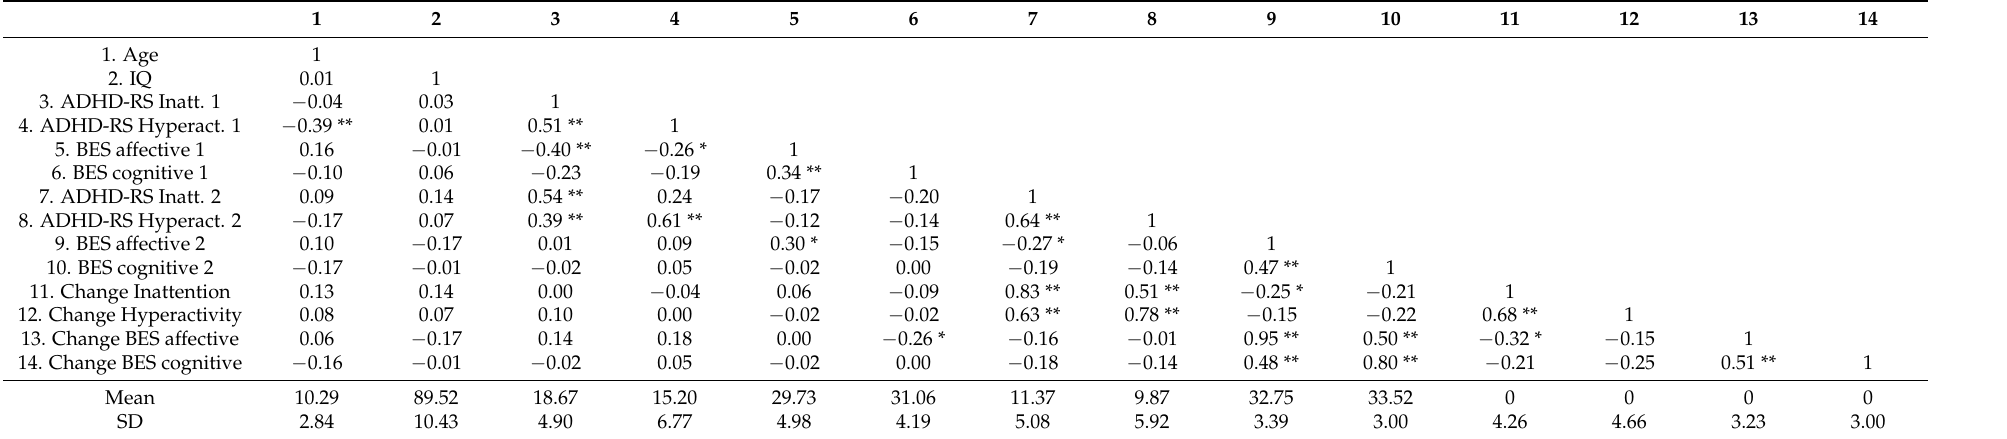
Table 1. Correlations, means and standard deviations of the study